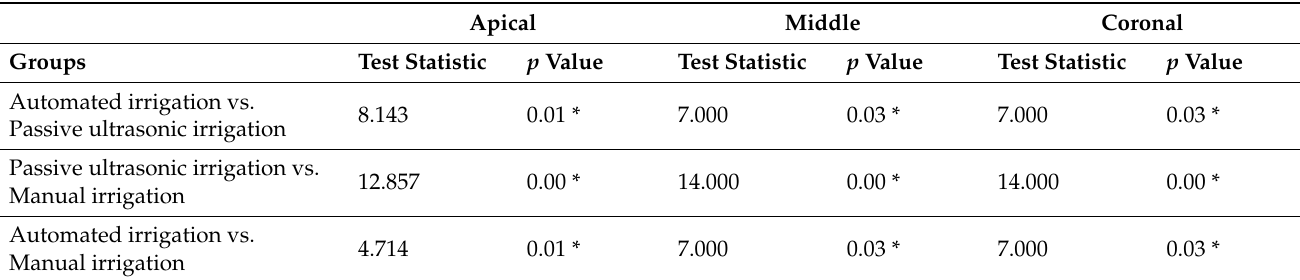
Table 2. Pairwise comparison of mean debris